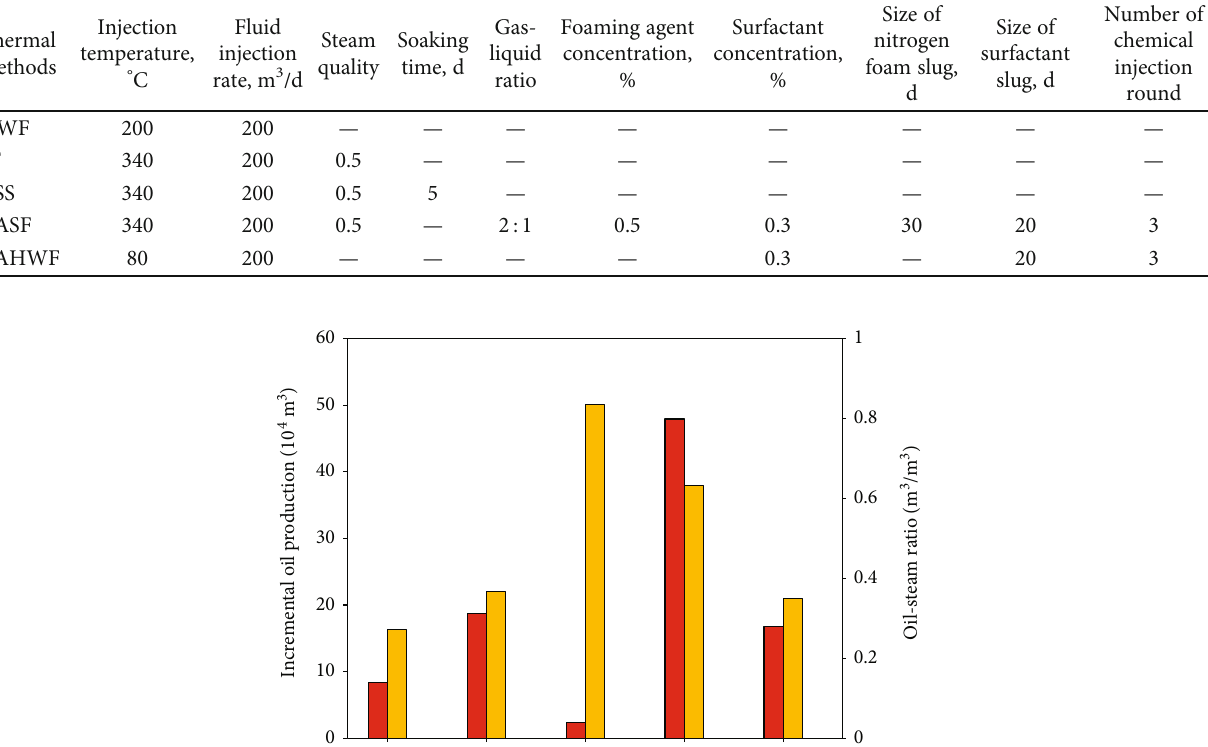
Table 4: The operational parameters of various thermal